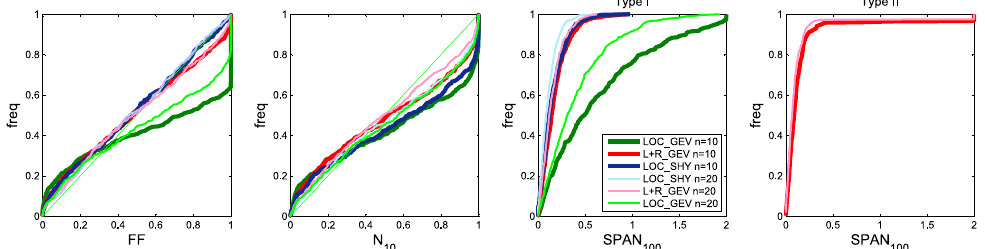
Fig. 9. Reliability ( FF , N 10 ) and stability (SPAN 100 – type I, SPAN 100 – type II) indices for three implementations, using 10 or 20years of local data for